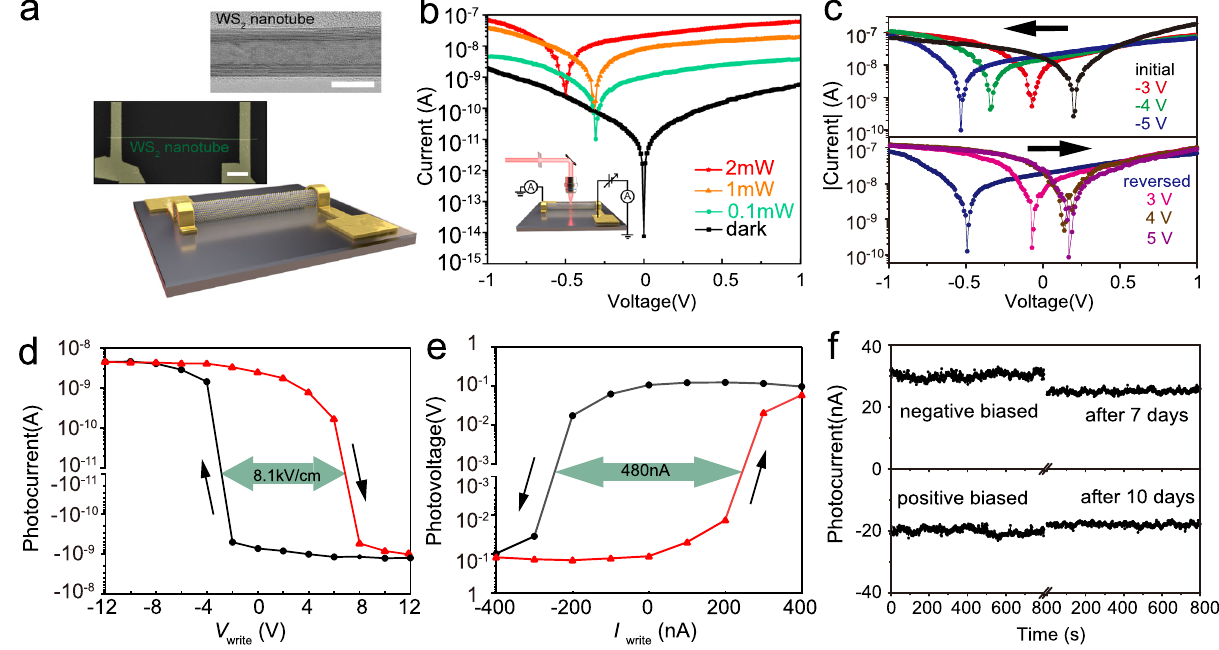
Fig. 1 | Programmability of the photovoltaic effect in WS 2 nanotube. a Upper: transmission electron microscopy image of a multiwall WS 2 nanotube, scale bar: 10nm.Middle:scanningelectronmicroscopyimage(colored)oftheWS 2 nanotube device, scale bar: 2 μ m. Lower: schematic of the WS 2 nanotube device. b Log scale I – V curves with 633nm laser spot focused at the middle of the channel with the power of 0W, 0.1mW, 1mW, and 2mW. Insert: Schematic diagram of the